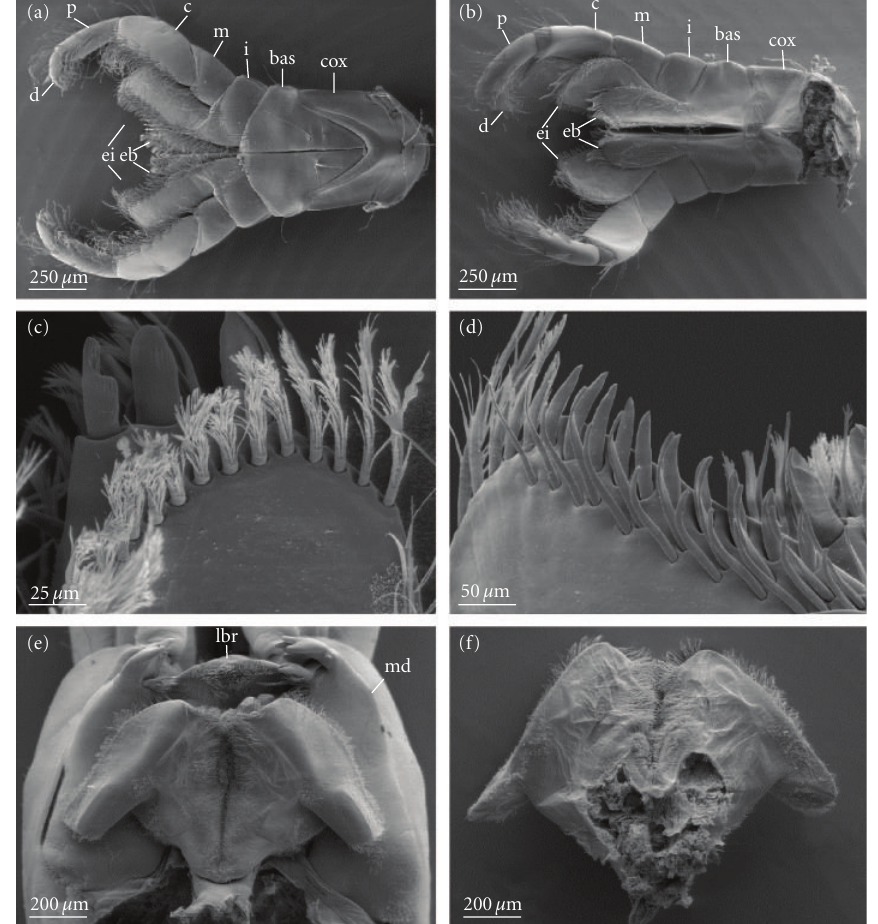
Figure 7: SEM images of maxillipeds and paragnaths of Echinogammarus berilloni : (a) maxillipeds in posterior view in situ ; (b) maxillipeds in anterior view; (c) distal setation of endite of left basipod in anterior view (cf. eb in (b)); (d) median setation of endite of right ischium in posterior view (cf. ei in (a)); (e) paragnaths in posterior view demonstrating also the position against labrum and mandibles in situ ; (f) paragnaths in anterior view. Abbreviations other than in previous figures: lbr: labrum; md: